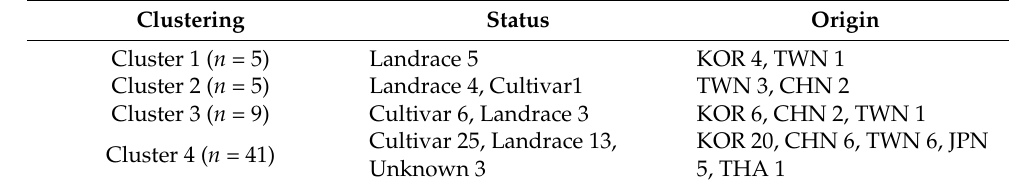
Table 5. Information status and origin in germplasms divided by four clusters.